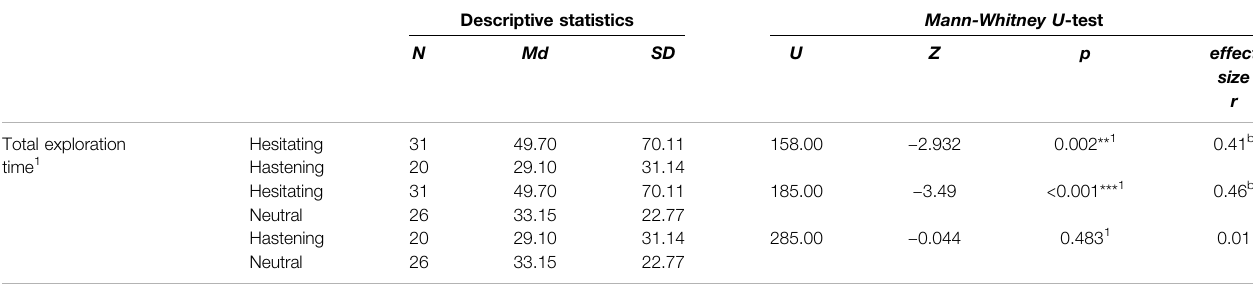
TABLE 3 | Test statistics for post-hoc Mann-Whitney U-test regarding exploration